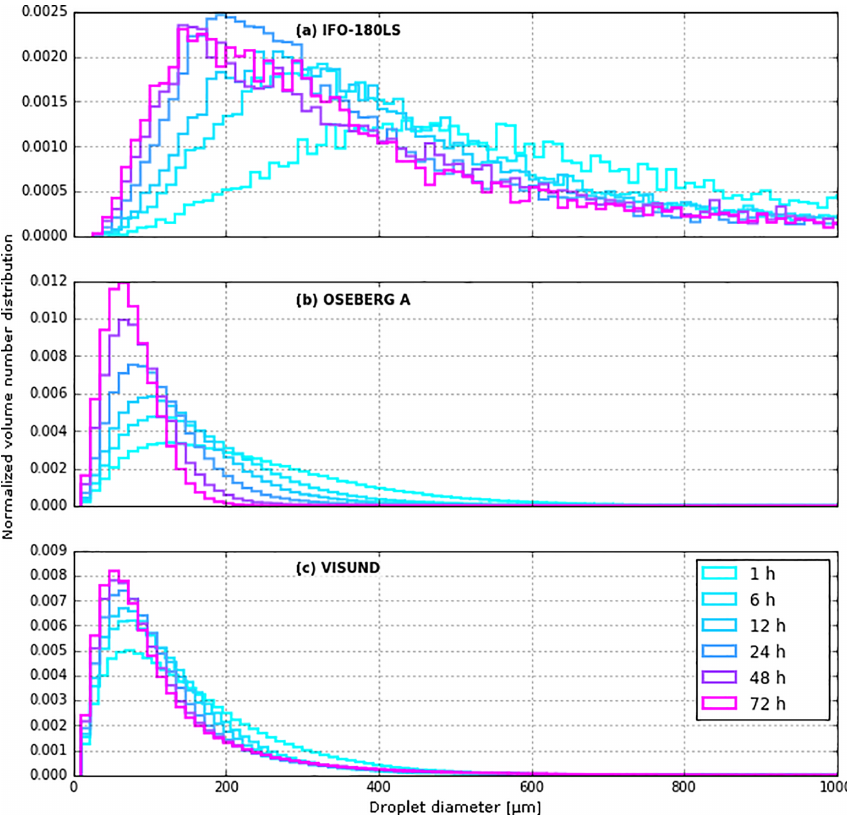
Figure 6. Droplet size mass distributions for three different oil types based on 72 ensemble simulations for each oil type. The colors in each plot show the temporal evolution of the droplet size distribution.